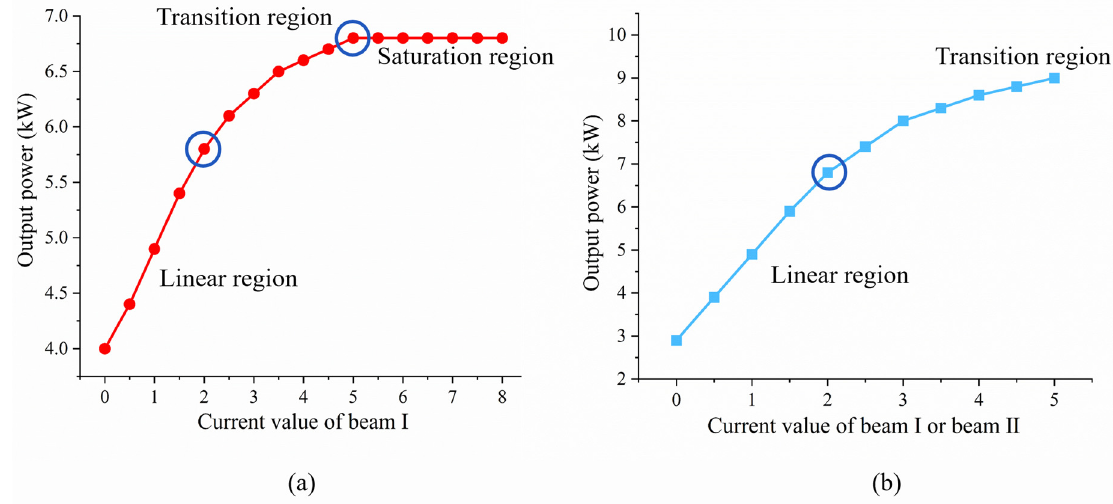
Figure 12. Under the condition that the other beam currents are constant, ( a ) variation trend of output power with the current value of beam Ⅰ and ( b ) variation trend of output power with the current value of beam Ⅰ or beam Ⅱ .